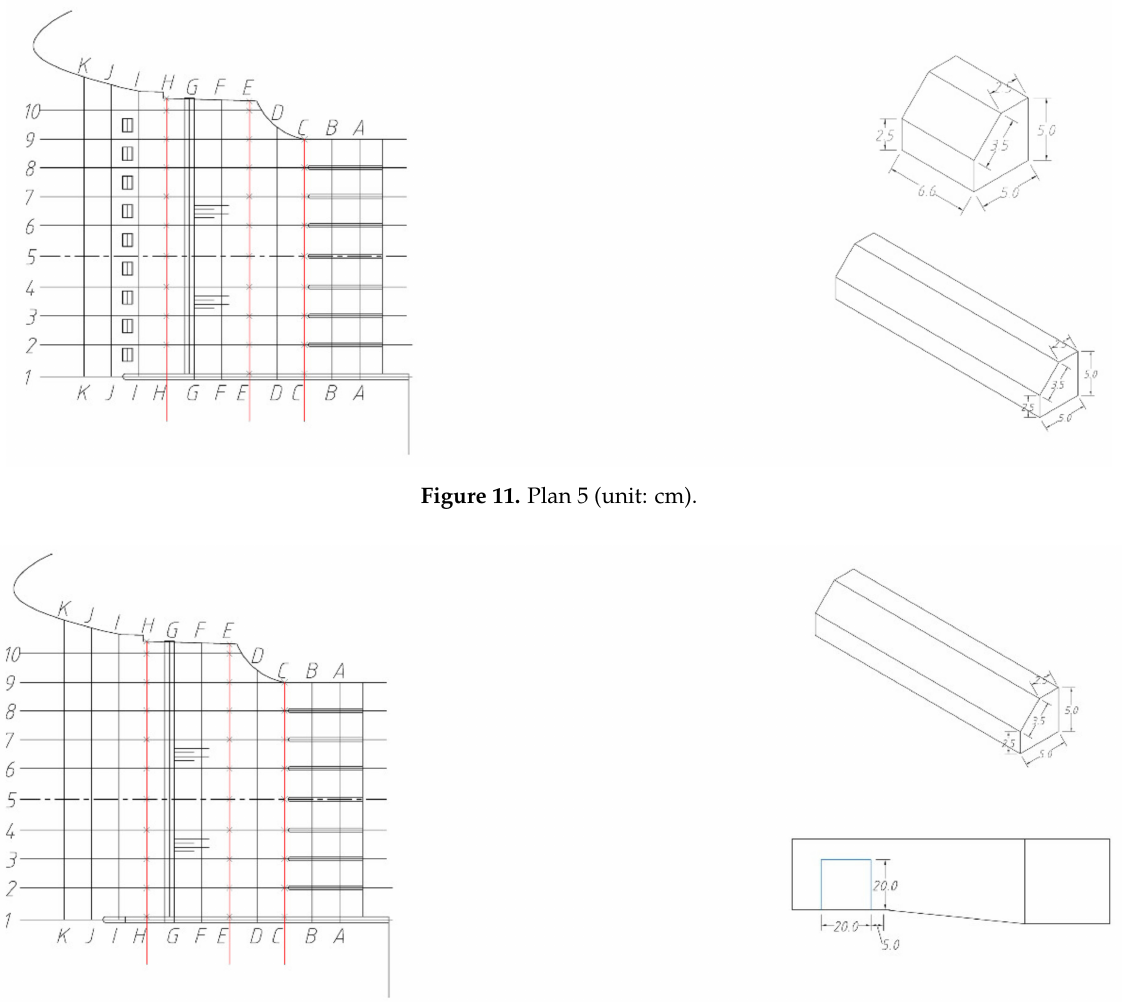
Figure 12. Plan 6 (unit: cm).